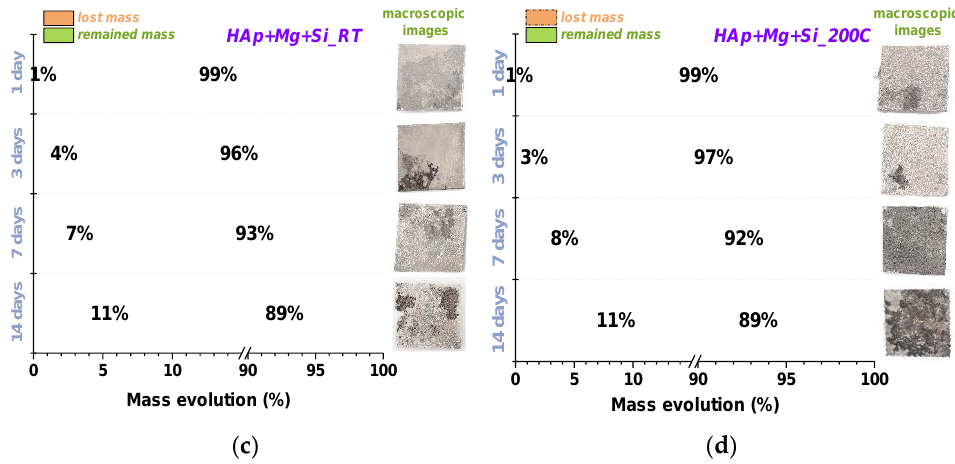
Figure 8. Evolution of mass during in vitro degradation tests: ( a , b ) Tests in SBF solution; ( c , d ) Tests in DMEM solutions, along with the optical images of the samples after the tests.